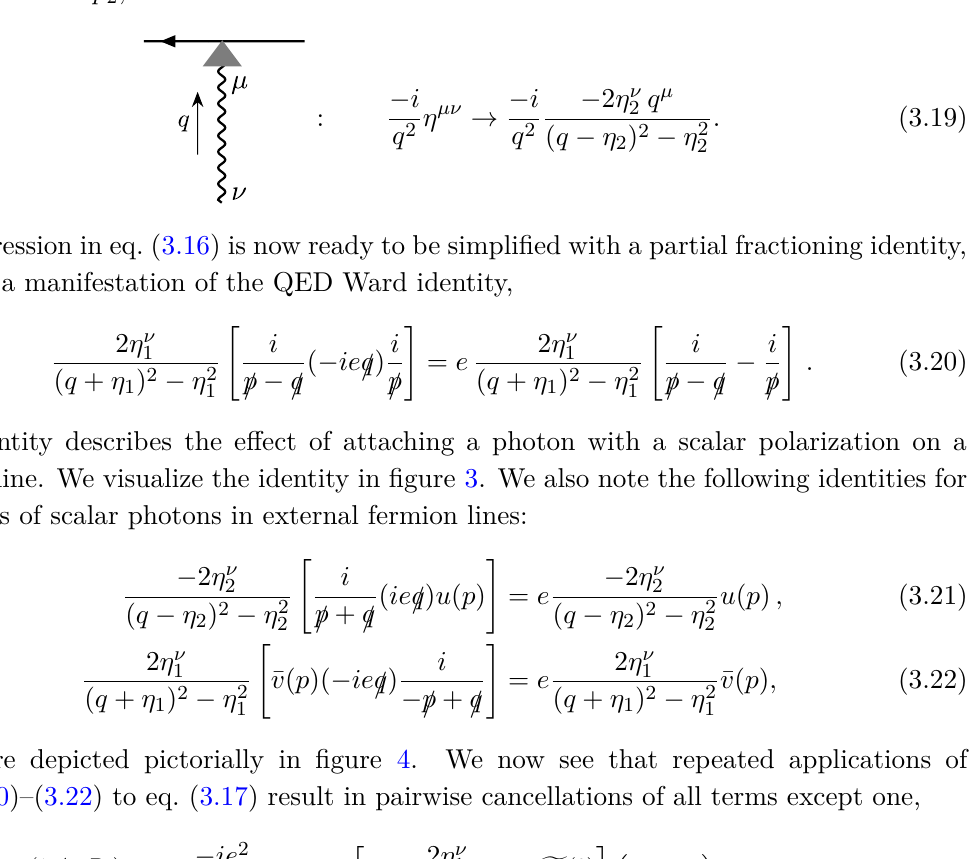
Figure 3. A pictorial representation of a tree Ward identity eq. (3.20). Fermion-fermion-photon vertices with arrowed photons denote a contraction of the QED triple vertex with the photon momentum − ieγ µ → − ie/q , multiplied by appropriate extra factors shown on the left-hand side of eq. (3.20). The photon can be regarded as an external photon with a scalar polarization vector, equal to its momentum. The double lines represent insertions of momenta without a photon-fermion vertex, multiplied by appropriate factors as shown on the right-hand side of eq. (3.20). separation from p 2